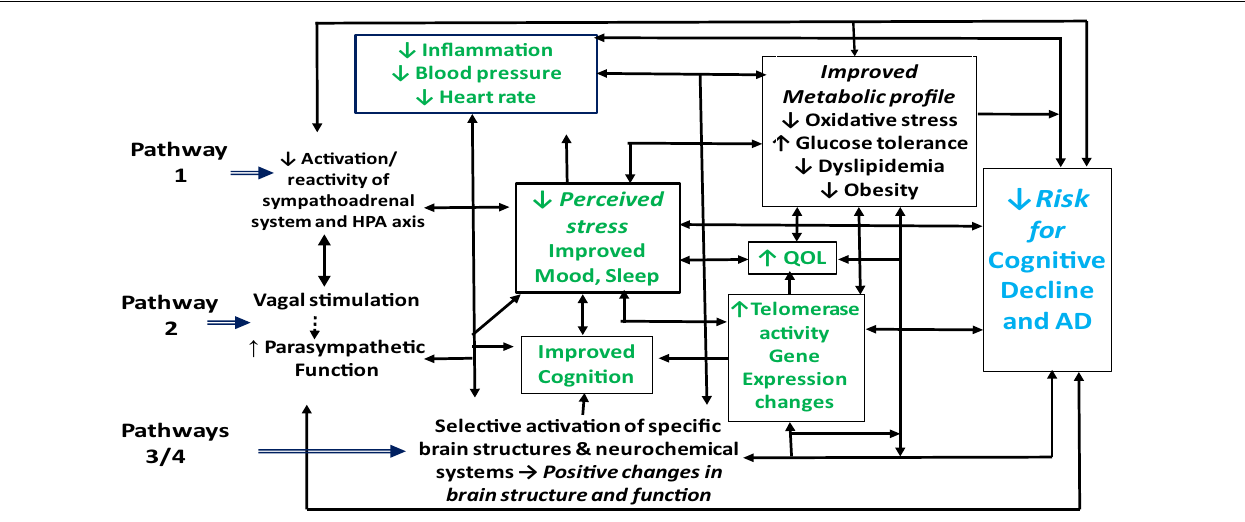
FIGURE 1 | Possible pathways by which meditation may improve health outcomes in adults with cognitive impairment .